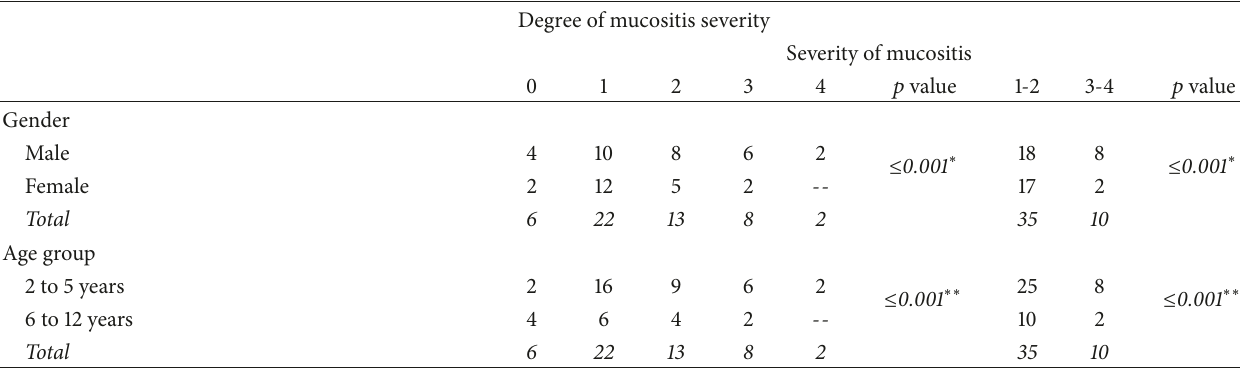
Table 2: Patients according to the degree of mucositis, grouped by severity of mucositis according to gender and age groups, expressed as number of patients.